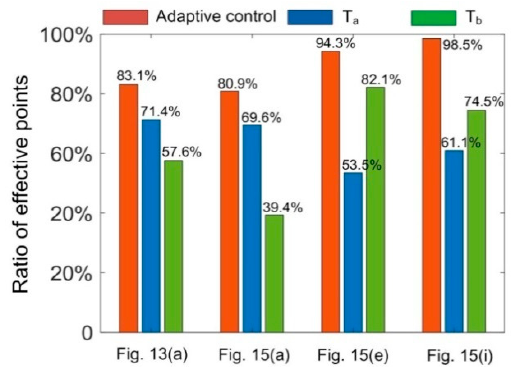
Figure 16. Ratio of effective points for the measurement of different parts at varied exposure